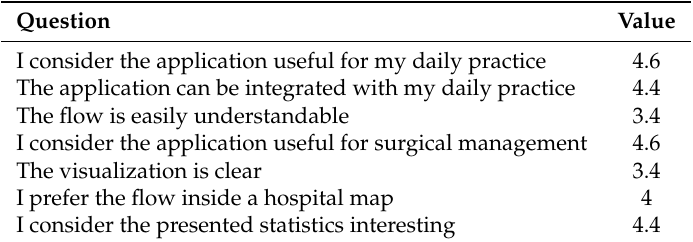
Table 7. Results of the evaluation questionnaire for health staff (Likert